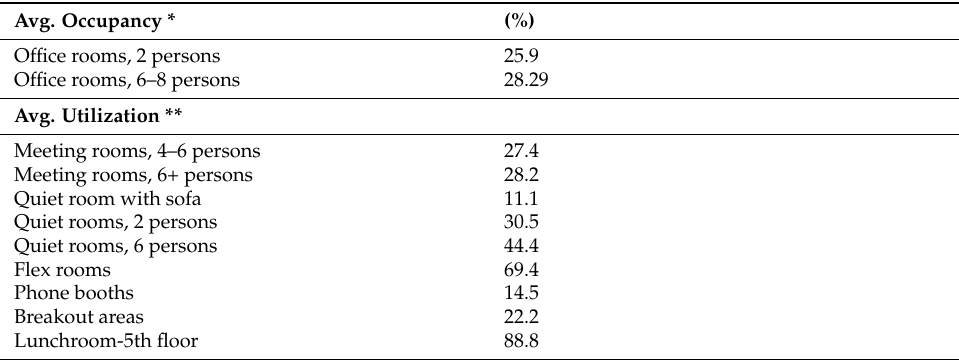
Table 4. Occupancy during a working